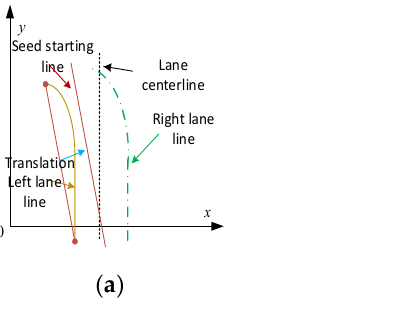
Figure 9. Search starting line: ( a ) Initial line diagram; ( b ) Initial line picture. Table 1. Basic rule of the global search of dynamic region of interest.